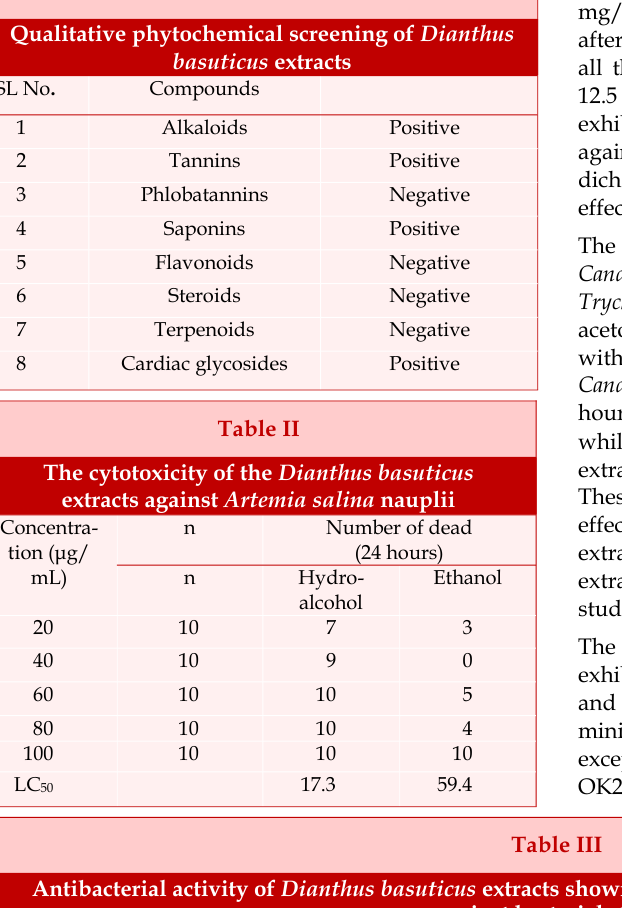
Qualitative phytochemical screening of Dianthus basuticus extracts SL No .